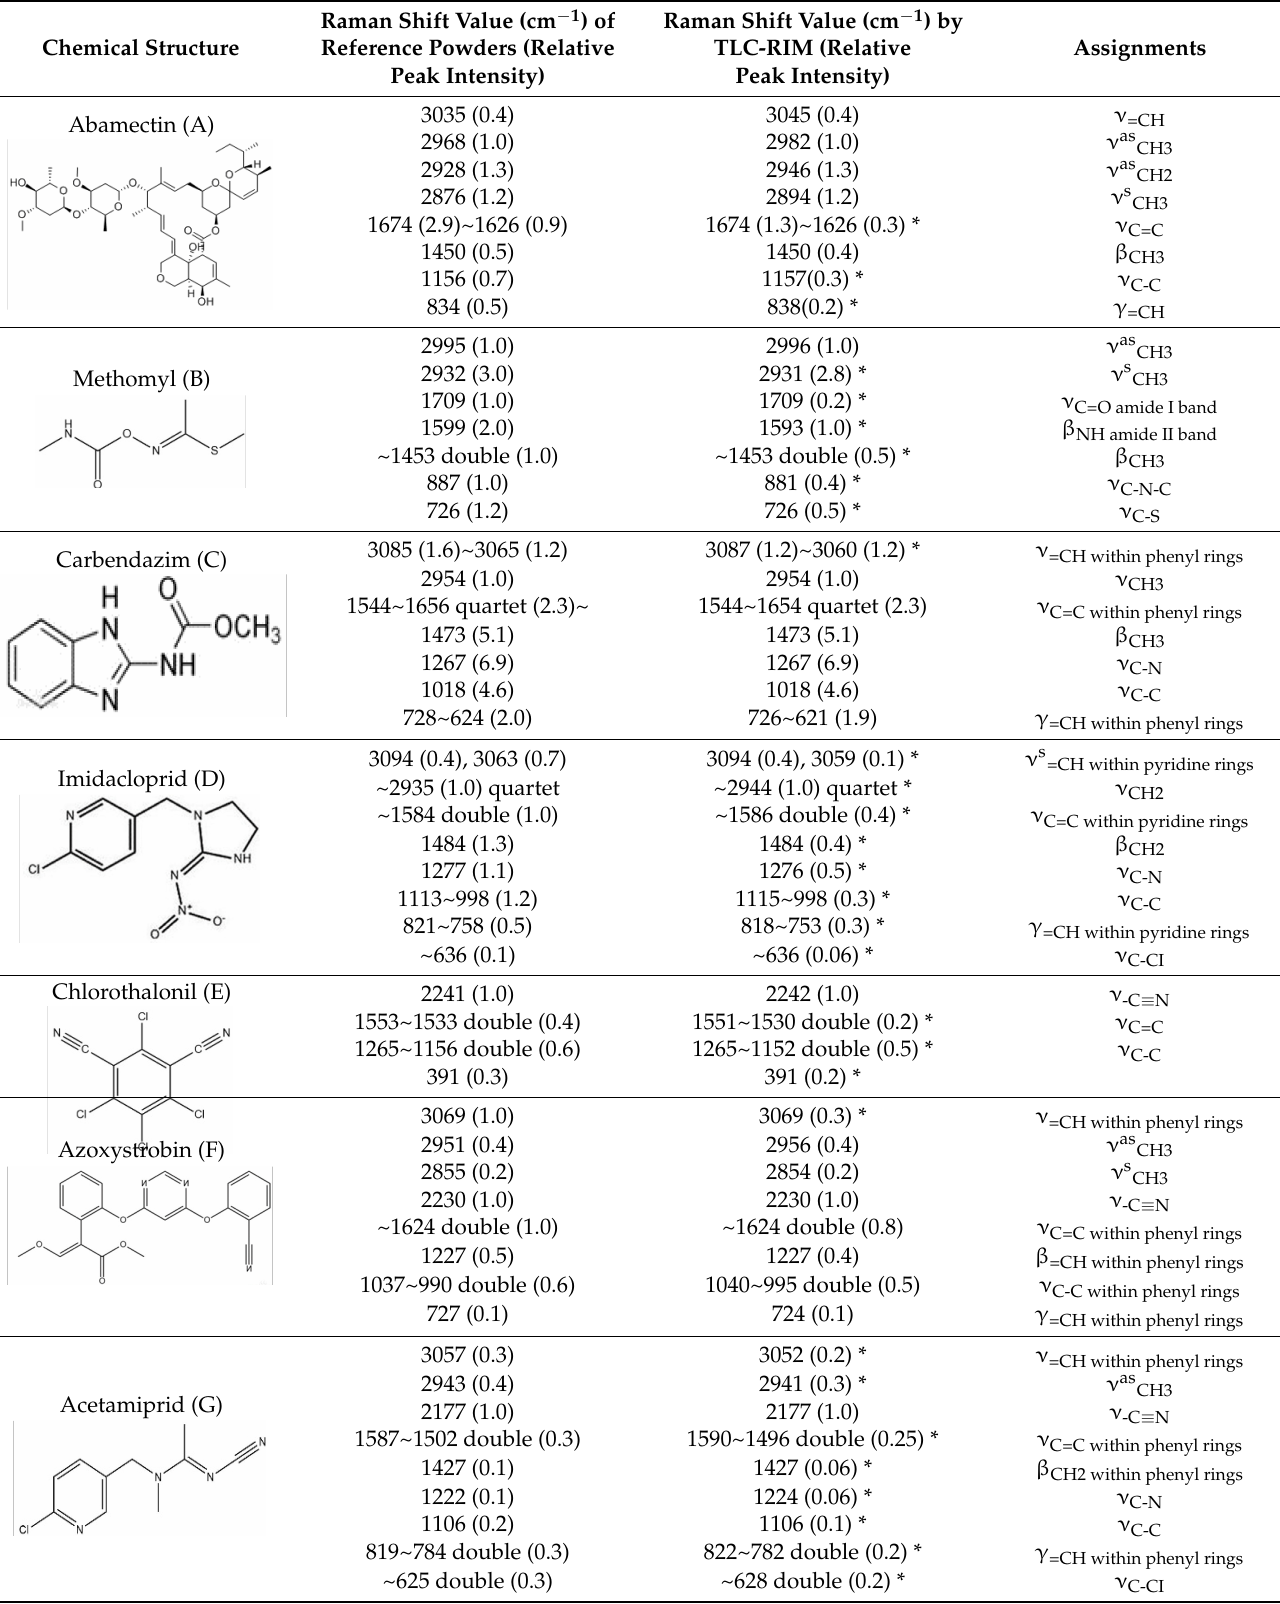
Table 1. The Assignments of Raman spectral characteristic peaks of the seven